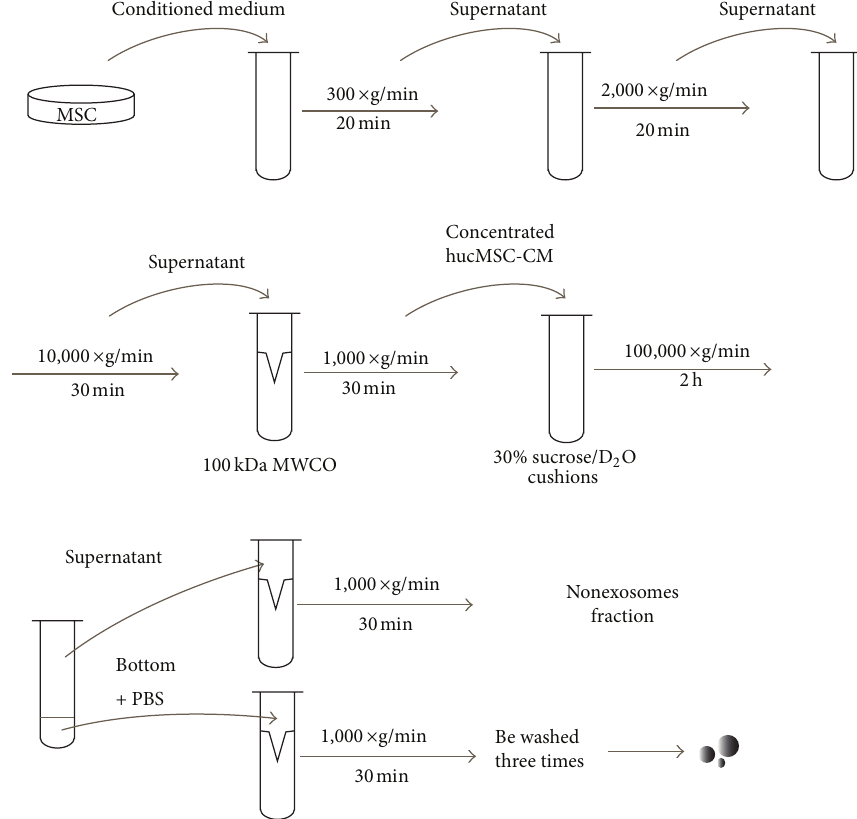
Figure 1: Separation process of exosomes derived from